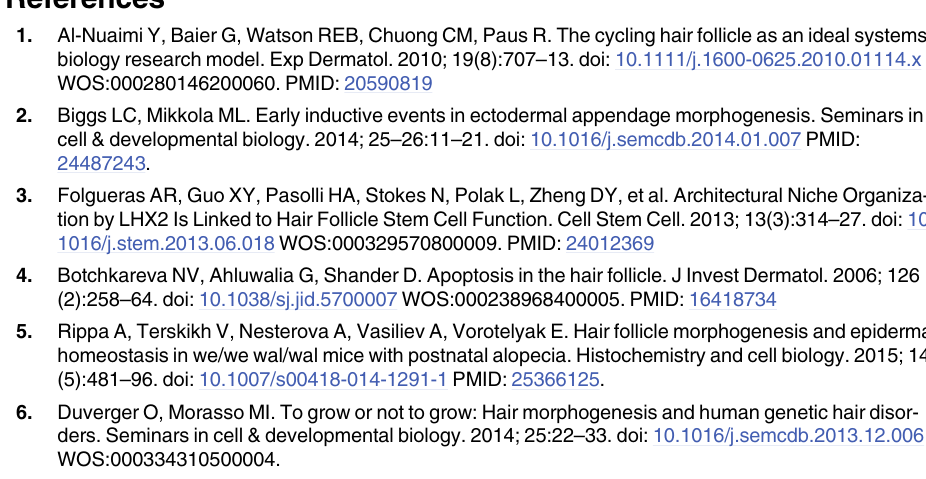
S1 Fig. Comparison of transcript length,ORF length, the number of exons and conserva- tion score of mRNA and LncRNA. (A) The transcript length distribution of mRNA and LncRNA.(B)The ORF length distribution of mRNA and LncRNA. (C) the number of exons of mRNA and LncRNA.(D) The cumulative distribution curve of mRNA and LncRNA conserva- tion scores. S1 Table. Differentially expressed genes and LncRNA between Stage 0 and Stage 1 of sec- ondary HF initiation. S2 Table. Cluster genes of differentially expressed LncRNAs in sheep skin during secondary HF initiation. S3 Table. Differentially expressed genes of PPAR signaling pathway in sheep skin between Stage 0 and Stage 1 of secondary HF initiation. S4 Table. Relevant information of gene and primer sequences for strand-specific